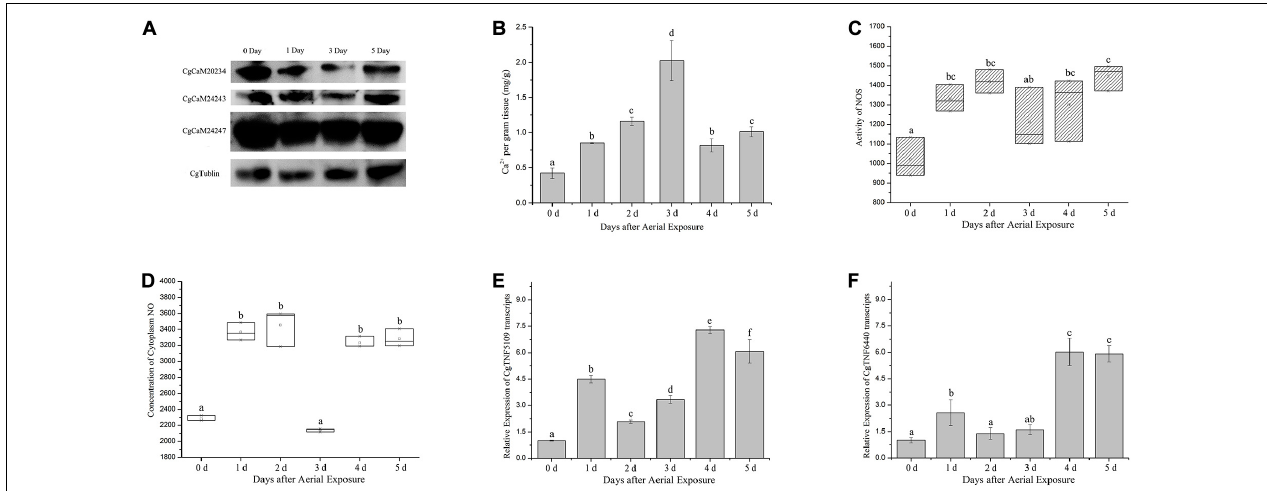
FIGURE 1 | Physiological and molecular changes in oyster hemocytes during emersion. (A) Protein levels of three CgCaM proteins including CgCaM20234, CgCaM24243, and CgCaM24247 during aerial exposure. Robust decreases were observed in all studied CgCaMs at the first and third day of emersion while CgTublin remained unchanged. (B) Ca 2 + concentration inside oyster hemocytes during emersion. A drastic increase of intracellular Ca 2 + was observed starting from the first day of stress and peaked at the third day of emersion. (C,D) NOS activity and NO concentration in oyster hemocytes during the emersion. Activity of NOS increased significantly in oyster hemocytes during aerial exposure and decreased slightly at the third and fourth day (C) . NO concentration inside oyster hemocytes increased significantly during the aerial exposure except for the third day when it dropped to the basal level (D) . (E,F) Alternations of CgTNF5109 and CgTNF6440 transcripts during the emersion. CgTNF5109 transcripts were found up-regulated markedly in oyster hemocytes during the emersion, especially at the first, fourth, and fifth day of stress (E) . CgTNF6440 transcripts were found accumulated drastically in oyster hemocytes at the fourth and fifth day of emersion (F)